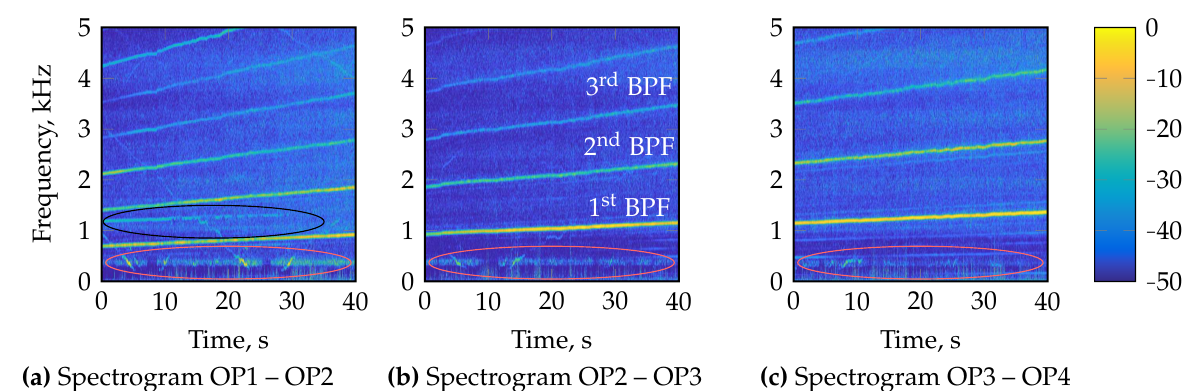
Figure 8. L W,A of the EDF unit, run between neighboring operating points. The scale is selected relative to the highest sound power level in the respective measurement range. The black and red circle mark detailed characteristics in the